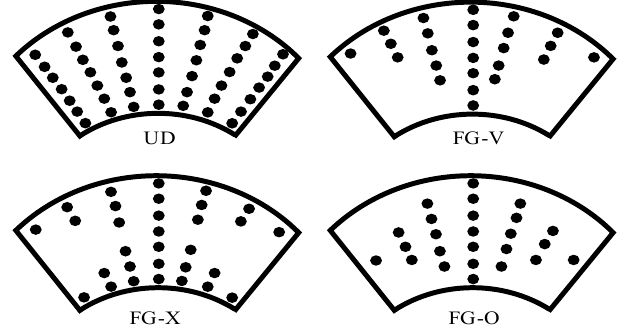
Figure 2. Configurations of various CNTRC truncated conical shells.